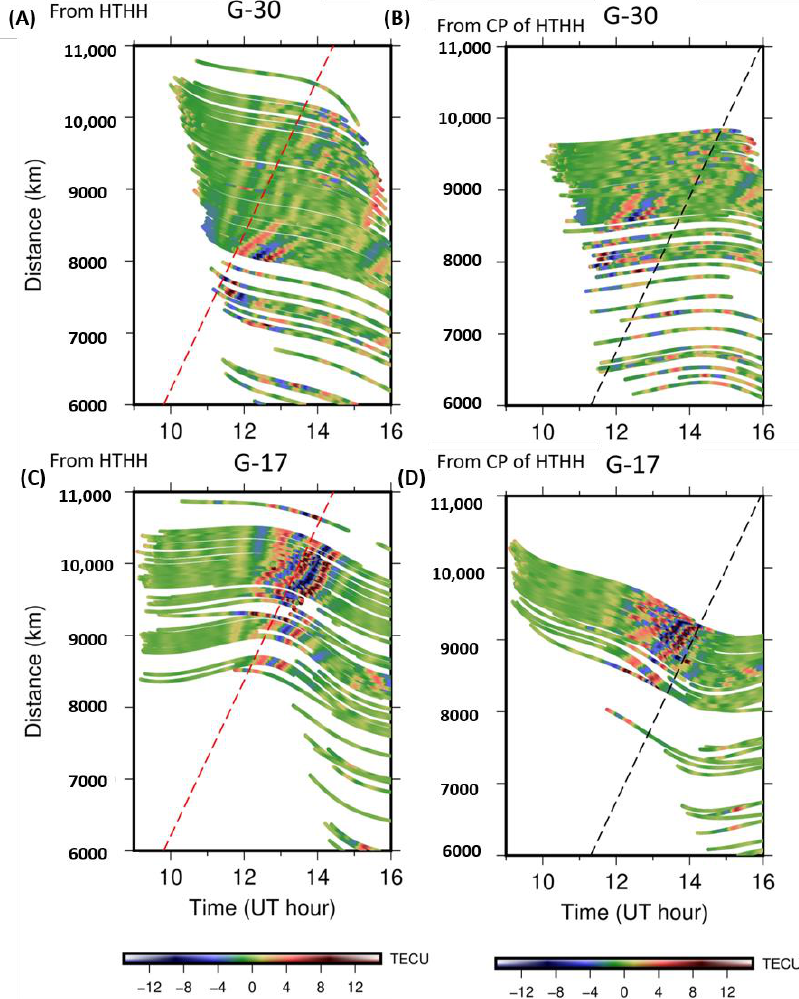
Figure 5. Wavelet analysis of STEC data time – distance (relative to conjugated point of HTHH) plot of G17 ( A , B ) and G30 ( C , D ) to find signatures of the possible passage of conjugated disturbances. In ( A , C ), distances are calculated from the HTHH volcano, while in ( B , D ), distances are calculated from the conjugate point (CP) of the volcano. The expected arrival times and velocities from HTHH and its CP are given as red and black dashed lines in ( A , C ), and ( B , D ), respectively.